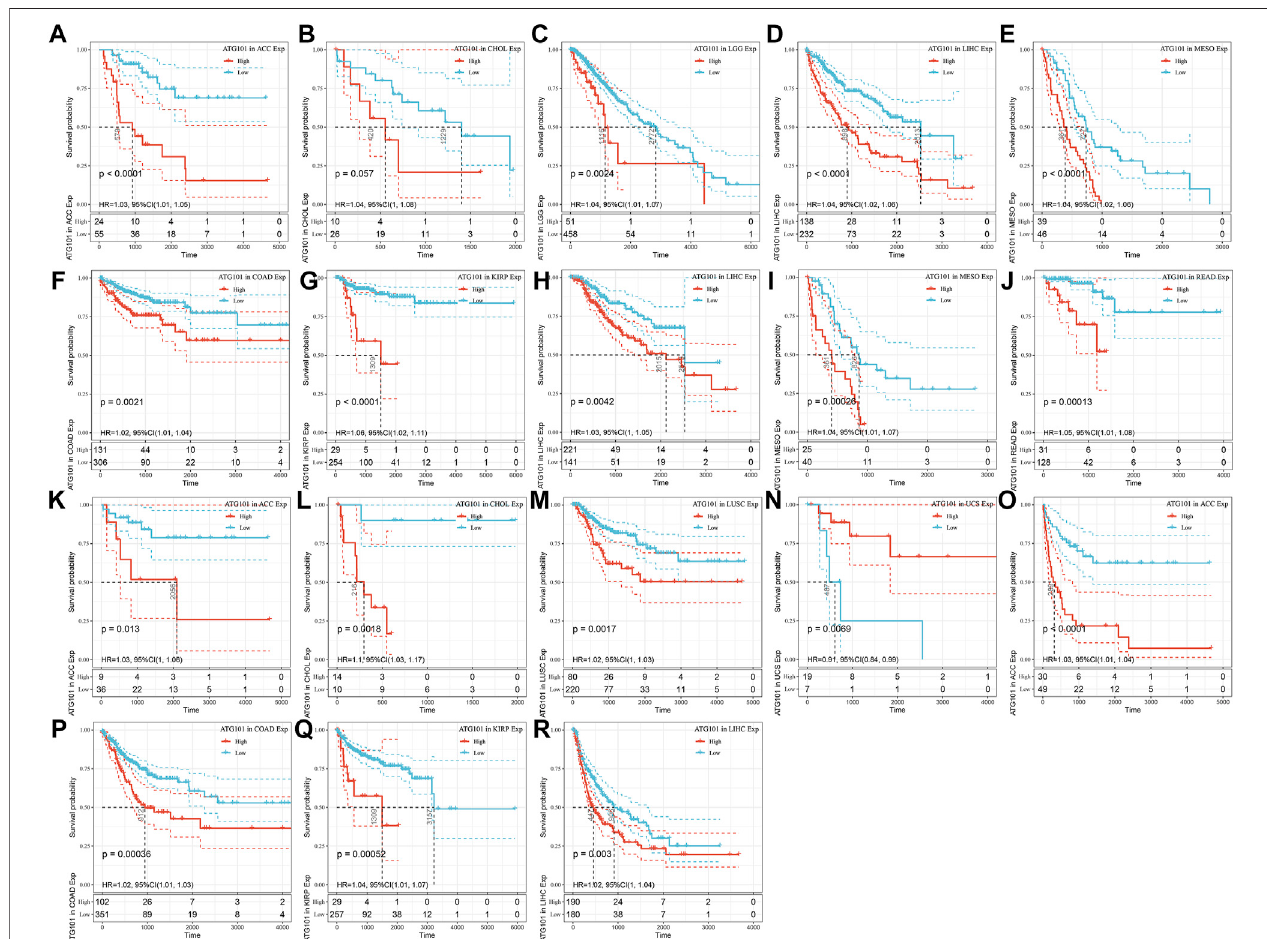
FIGURE2| TherelationshipbetweentheexpressionofATG101andtheprognosisofpatientswith33typesofmalignanttumoursfromtheTCGAdatabase. (A – E) Overall survival. (F – J) Disease-speci fi c survival. (K – N) Disease-free survival. (O – R) Progression-free